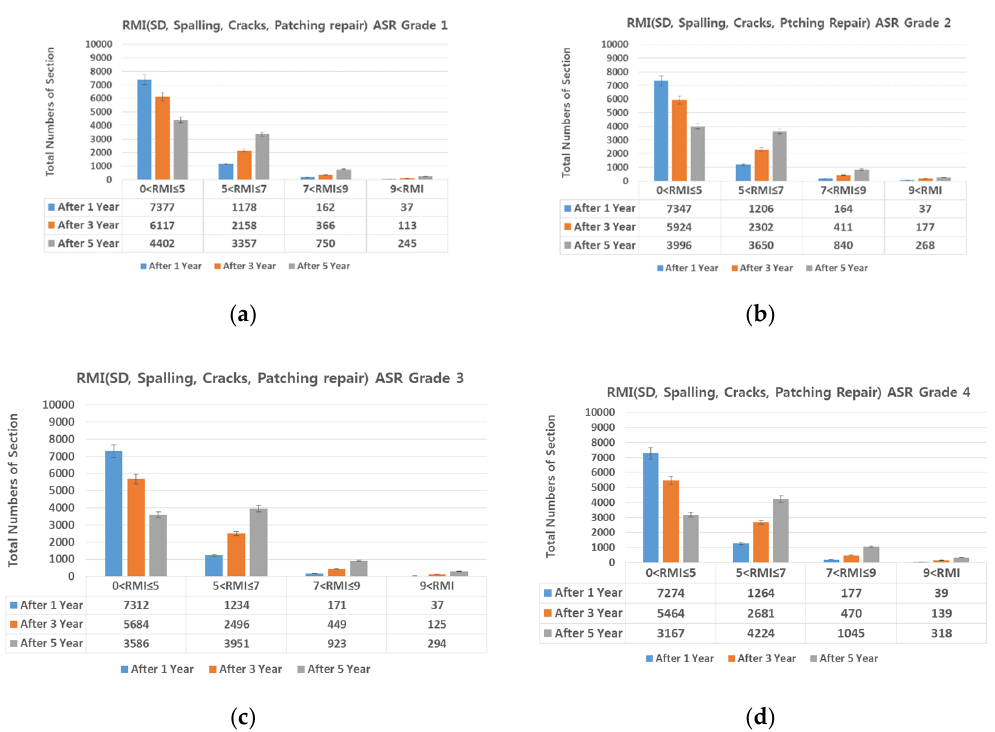
Figure 19. Change in number of sections per RMI with respect to SD. ( a ) spalling, cracks, patching repair, and ASR grade 1; ( b ) spalling, cracks, patching repair, and ASR grade 2; ( c ) spalling, cracks, patching repair, and ASR grade 3; and ( d ) spalling, cracks, patching repair, and ASR grade 4. On reducing the SD damaged area as described above, the number of sections with RMI one to five (good pavement condition) increased in the following order: Patching, linear cracking, and spalling. For all three damage types, SD decreased by up to 70% after repair. For RMI of one to five at ASR one assuming all three types of damage were repaired, 84%, 70%, and 50% of the sections had a good RMI after 1, 3, and 5 years, whereas the corresponding values at ASR four were 68%, 44%, and 23%. That is, as the ASR grade worsens, the proportion of the pavement in good condition decreases. However, this is favorable for extending the life of the pavement when performing preventive maintenance based on damage type as in research papers [6,7]. In addition, repairing damage through a combination of repair measures is more advantageous than through a single measure. 4.3. SD (Surface Distress ) and IRI (International Roughness Index)-Based Preventive Maintenance Compared with the reduction in SD damaged area due to repair, after applying cross-section repair and crack sealing to prevent spalling, linear cracks, and patching and applying diamond grinding to secure IR smoothness, relatively more sections were of RMI one to five, indicating good pavement conditions with smoothness of IRI 1.5 or lower. This indicates that IRI smoothness repair is more advantageous than SD damage repair in terms of preventive maintenance. However, SD damage repair and IRI smoothness repair can be implemented together to further extend the service life of concrete pavements.